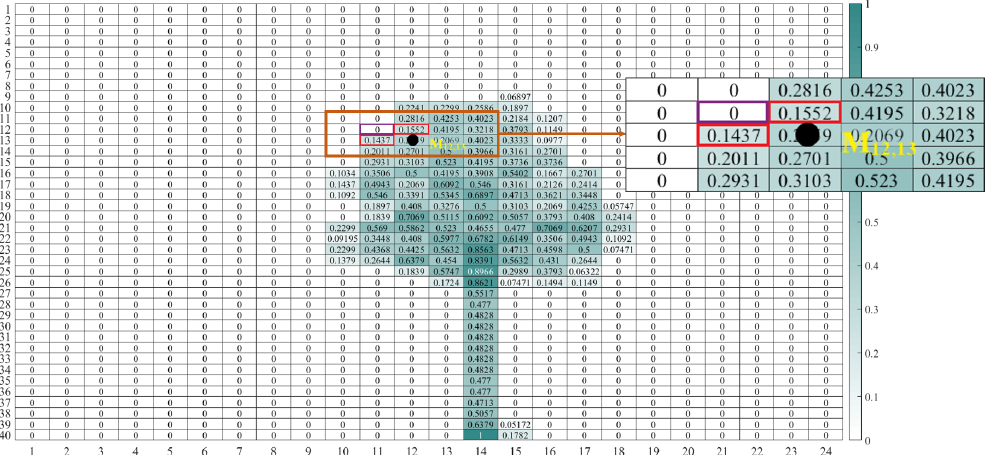
Figure 13. Tree heatmap (third obstacle).